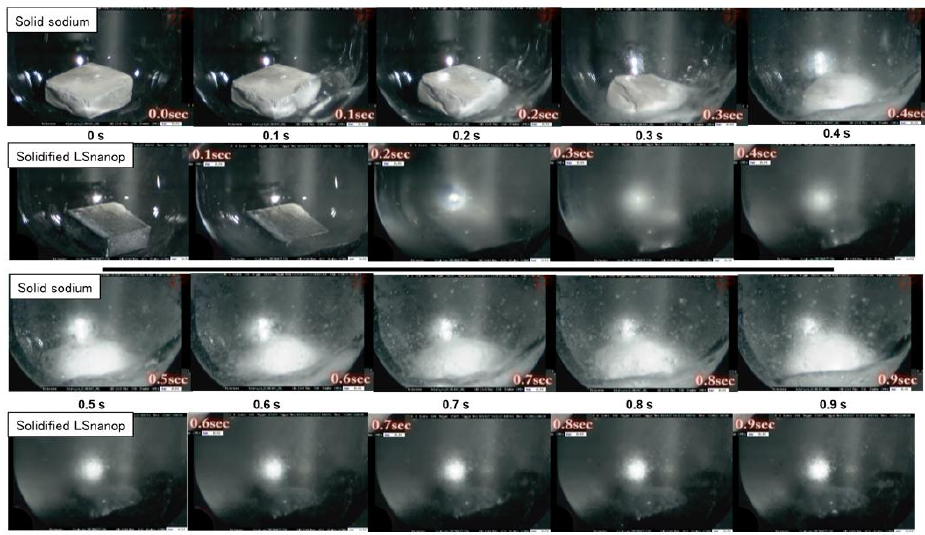
Figure 9. A comparison of the reaction to water between the solidified LSnanop and solid Na.